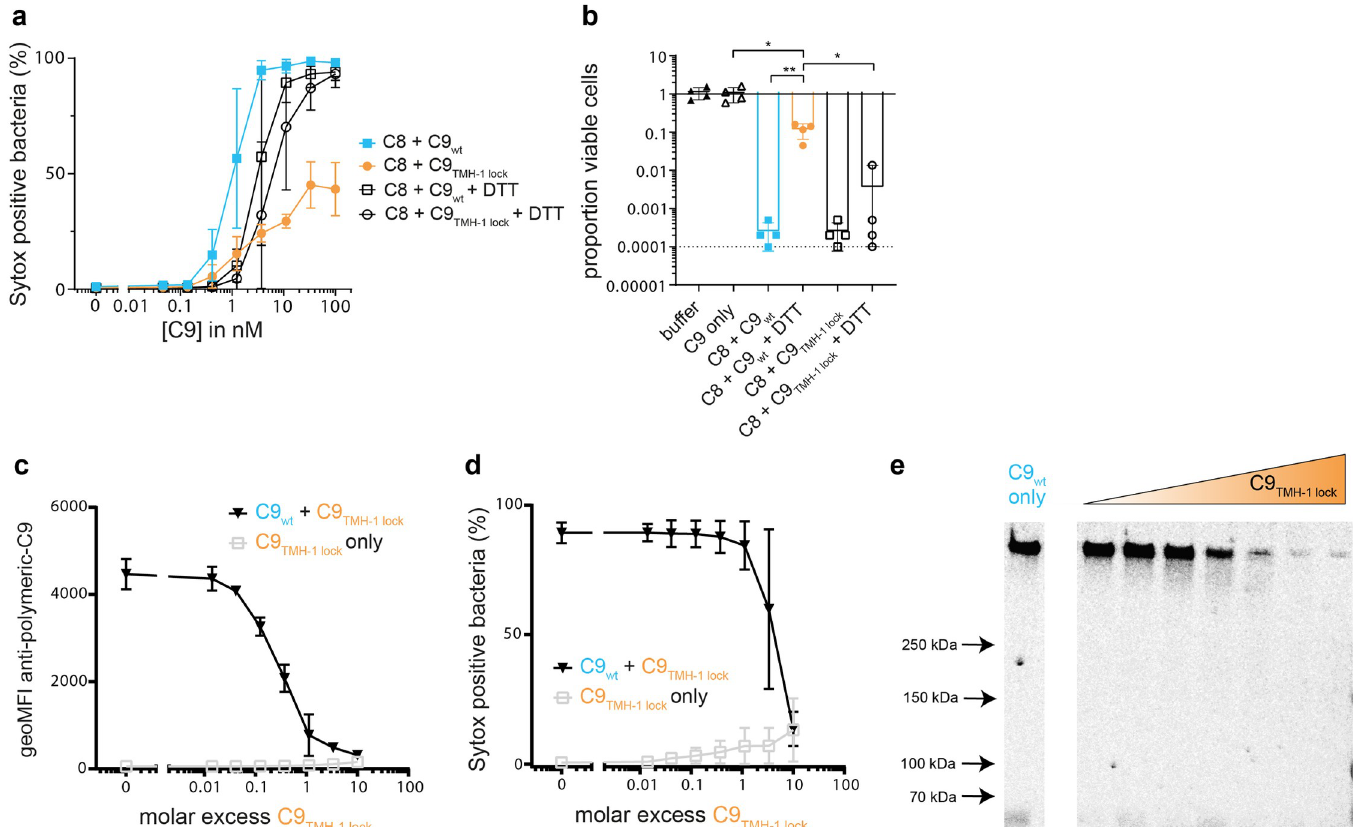
Fig 2. Polymerization of C9 enhances bacterial killing by MAC pores. E . coli MG1655 was labelled with C5b-7 by incubating in 10% C8-depleted serum for 30 minutes. Bacteria were washed and next incubated with 10 nM C8 for 15 minutes. a-b) A concentration range of C9 wt or C9 TMH-1 lock was added in the absence or presence of 10 mM DTT for 30 minutes. a) Sytox was used to determine the percentage of cells that have a damaged bacterial IM by flow cytometry as read-out for bacterial killing. b) Bacterial viability was determined by counting colony forming units (CFU’s) and calculating the proportion of viable cells for 100 nM C9 condition (a) compared to C5b- 7 labelled bacteria in buffer. The horizontal dotted line represents the detection limit of the assay. c-d) C5b-8 labelled bacteria were incubated for 30 minutes with 20 nM C9 wt and a concentration range of C9 TMH-1 lock . Bacteria were stained with AF488-labelled mouse anti-polymeric-C9 aE11-antibody (c) and Sytox to determine the percentage of cells that has a damaged bacterial IM (d) by flow cytometry. e) Bacterial cell pellets were analyzed by SDS-PAGE for in-gel fluorescence of Cy5-labelled C9 wt to distinguish monomeric-C9 from polymeric-C9. From left to right, the molar excess of C9 TMH-1 lock from left to right is: 0 (C9 wt only), 0.016, 0.05, 0.14, 0.46, 1.1, 3.3 and 10. The SDS-PAGE image is representative for at least three independent experiments. Flow cytometry data are represented by geoMFI values or cell frequencies of the bacterial population. Data represent mean values +/- SD (a, c and d) of three independent experiments or individual values (c) of four independent experiments with mean +/- SD. Statistical analysis was done on 10 log-transformed data using a paired one-way ANOVA with Tukey’s multiple comparisons’ test (b). Significance was shown as � p � 0.05, �� p �